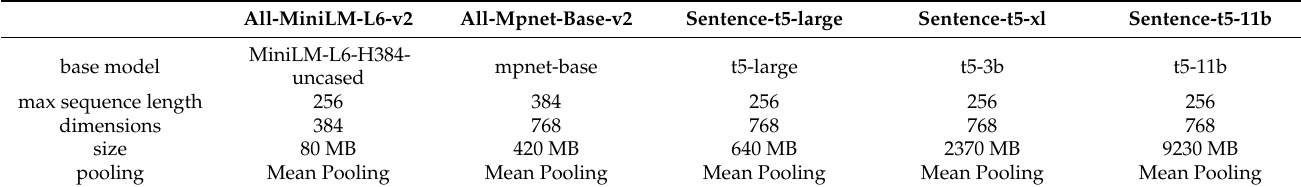
Table 8. Detailed description of the sentence embedding